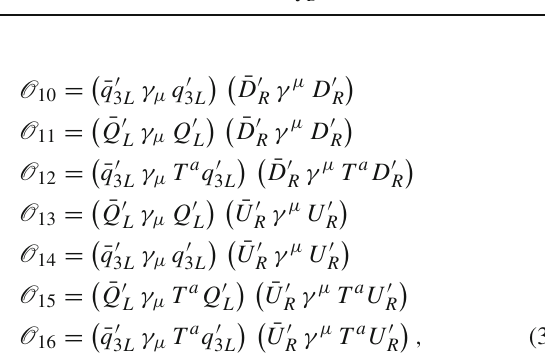
Table 4 Leading terms in each (cid:8) ( i , j , k ) structure. The column on the right specifies the leading term with non-trivial flavour structure. For (cid:8) ( 1 , 1 , 1 ) and (cid:8) ( 3 , 1 , 1 ) the contributions to the down and up sectors are different. For (cid:8) ( 1 , 3 , 1 ) and (cid:8) ( ¯ 2 , 2 , 1 ) the leading terms have trivial flavour structures and further spurion insertions are necessary to describe flavour changing effects